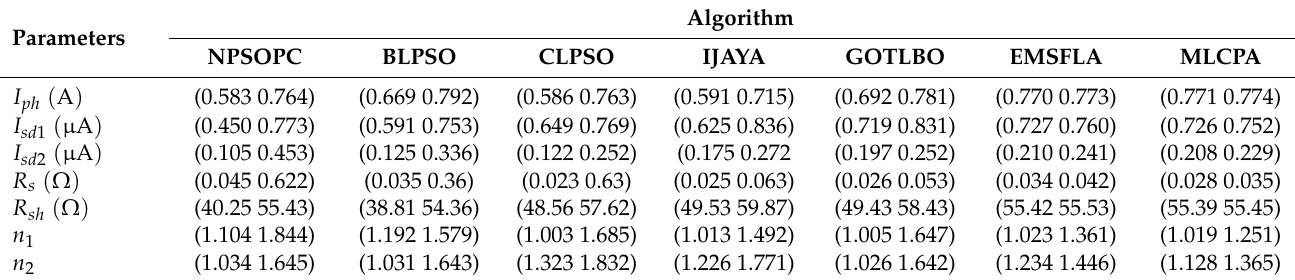
Table 13. Confidence intervals on